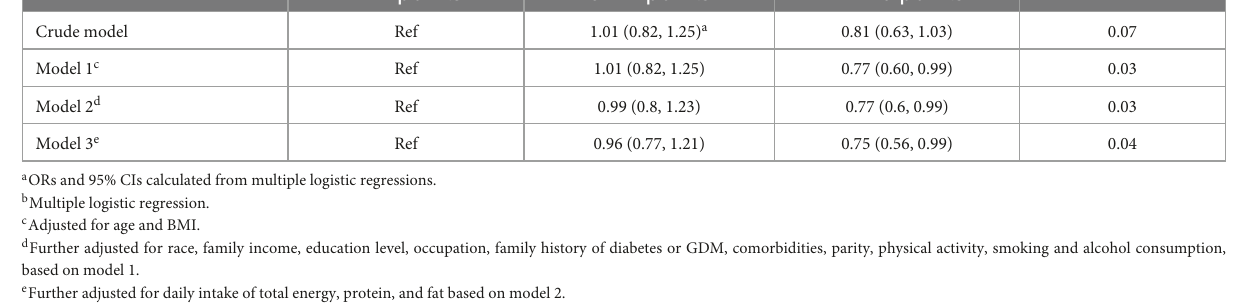
TABLE 4 Associations between each IQR increase in air pollutants and